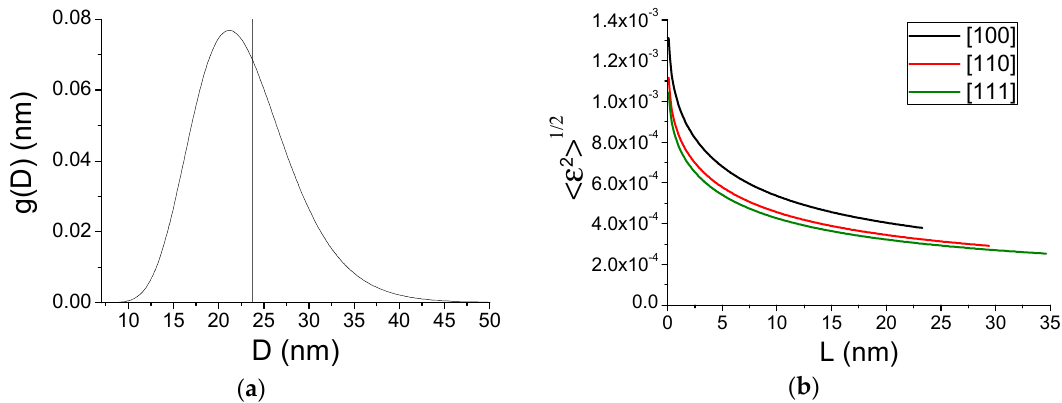
Figure 6. WPPM results. Lognormal distribution of cube edges, D ( a ) and microstrain distribution along three crystallographic directions: [100] (black), [110] (red), [111] (green) ( b ).